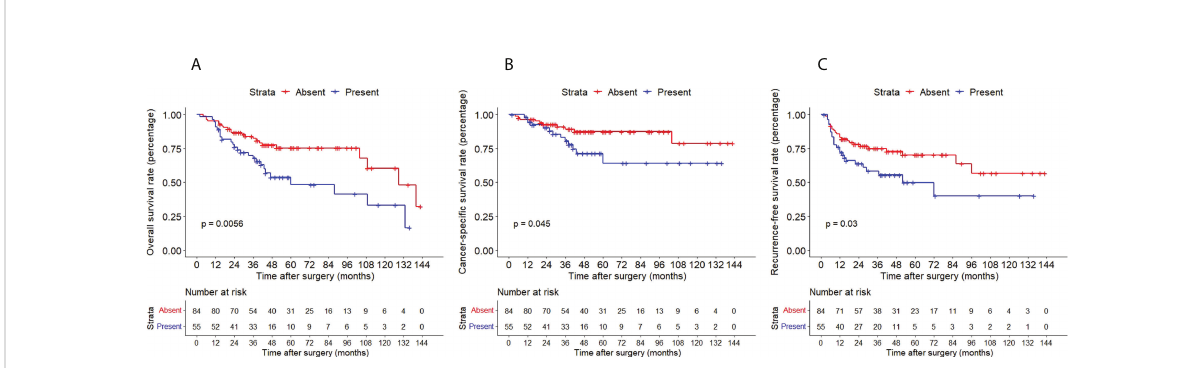
FIGURE 4 Kaplan – Meier curves for OS (A) , CSS (B) and RFS (C) of patients with UTUC according to hydronephrosis. OS, overall survival; CSS, cancer- speci fi c survival; UTUC, upper tract urothelial carcinoma; IVR, intravesical recurrence.